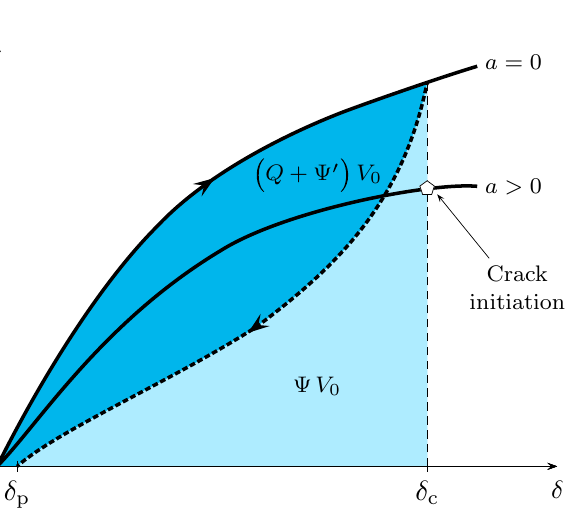
Figure 4. The schematic of the load–displacement curve for a non ideal rubber-like material. The lighter shaded area is the elastic stored energy, (cid:31) V 0 , and the darker shaded area is the summation of the heat and dissipation energy and the free energy in other forms, displacement δ c . δ p is the permanent deformation after